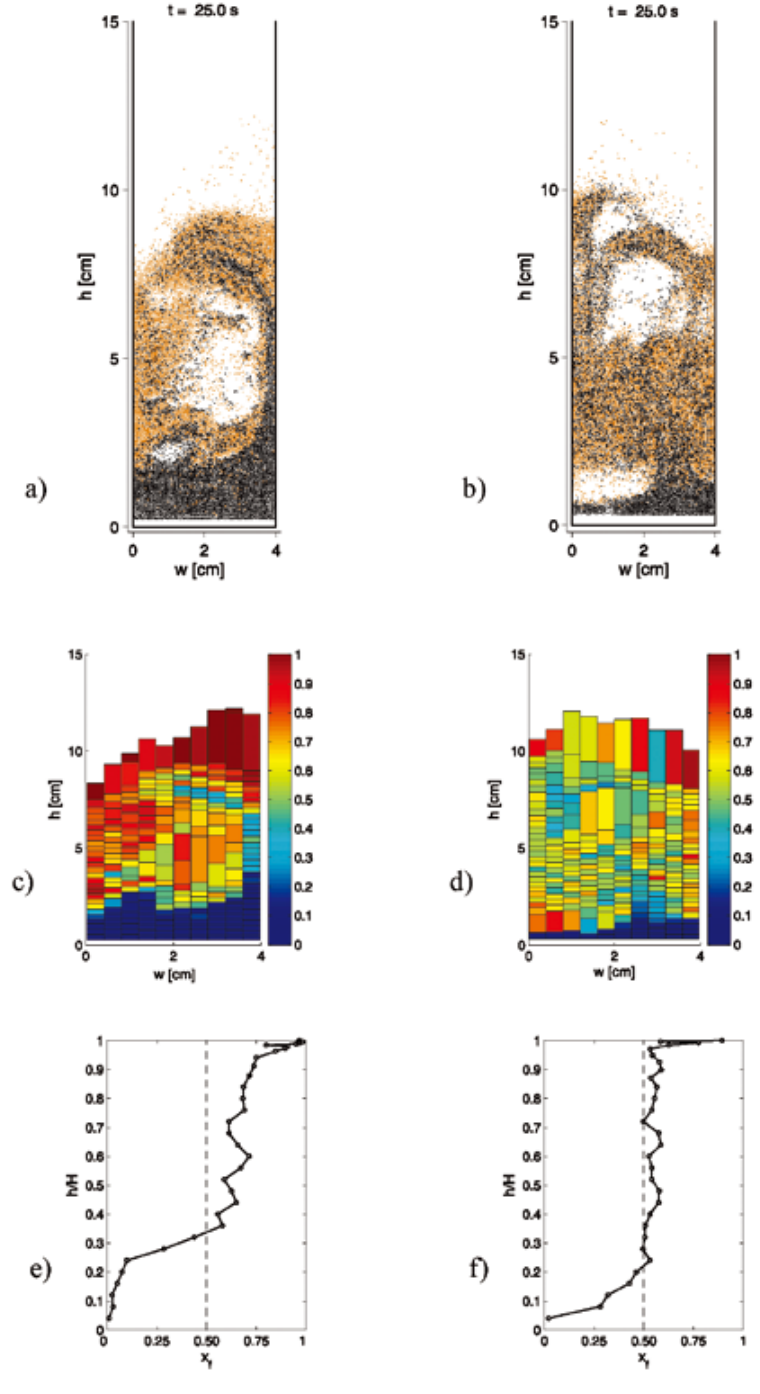
Fig. 4 Simulation snapshots (a,b) showing flotsam (orange) and jetsam (black) particles, flotsam volumetric fraction colour map (c,d) and flotsam fraction profile along a dimensionless bed height (e,f), at t = 25 s. Plots in the left column: u * = 1.25; plots in the right column: u * =